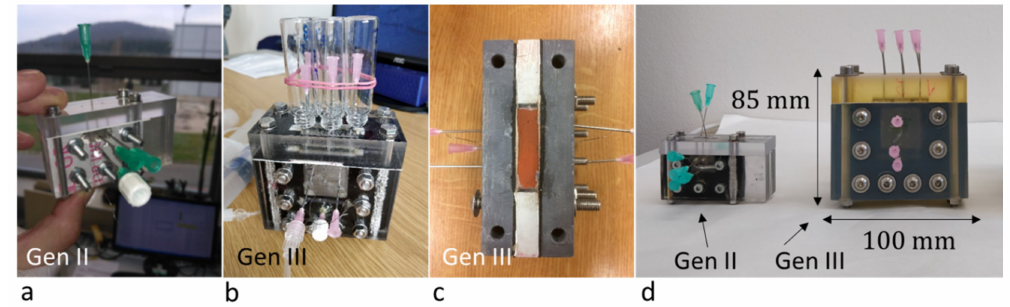
Figure 2. Comparison of “Gen. II” and “Gen. III” units built at TUL. ( a ) Gen II was built based on [21] ( b ) Gen III unit made of transparent polycarbonate, ( c ) top-down view of Gen. III unit made of polyvinyl chloride, without the separator. ( d ) comparison of the latest (3D printed) Gen. III unit with the Gen. II unit. Table 1. Comparison of desalination performance between our units built at the Technical University of Liberec (TUL) and the results reported by [20] (marked as Reference units) at the same dimensionless current, a parameter defined by Equation (1). The number presented in the reference unit column expresses the desalination performance of Schlumpberger’s reference unit at the same dimensionless current as was used to characterize the Gen. II and III units, respectively. The “Gen. II unit” used silica glass frit and a design very similar to the reference unit, and the “Gen. III unit” was a scaled-up unit described above, fitted with silica ceramics with the porosity and pore size comparable to the glass frit. Desalination (%) Dimensionless Current